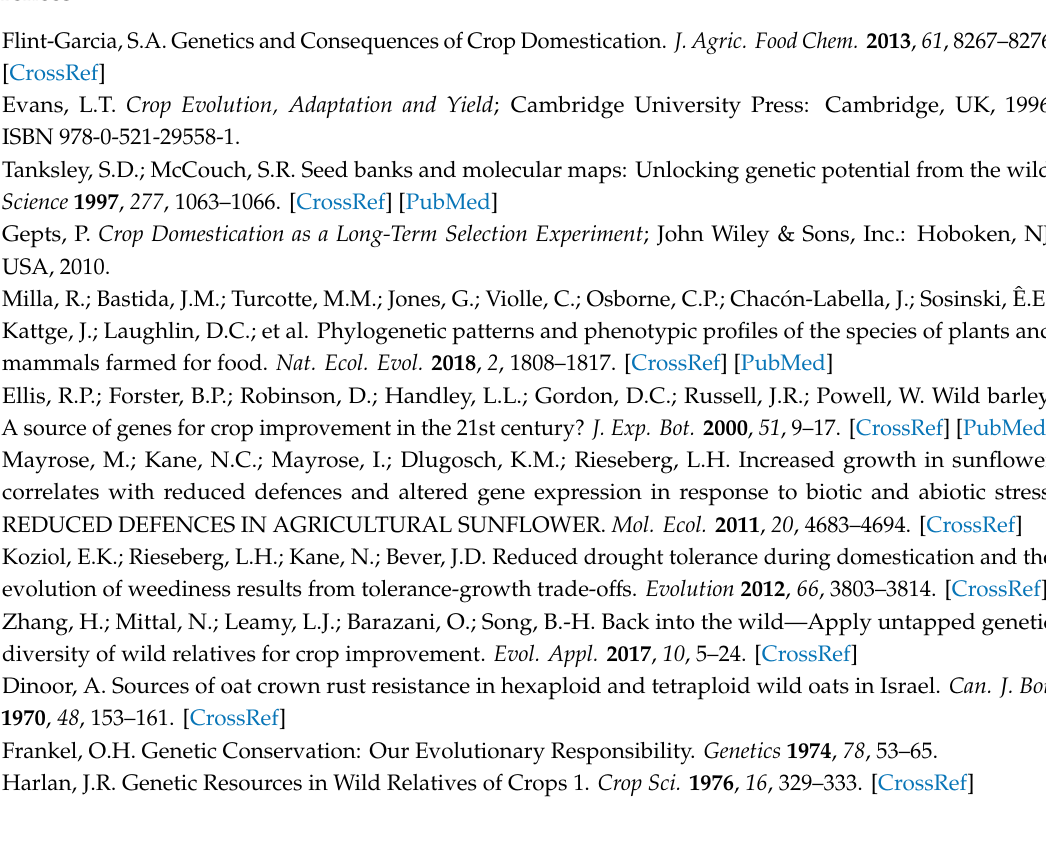
Figure S1: Elemental Content within Tissue Type, Figure S2: Element MRAA within Tissue Type, Figure S3: Top Three Size-Independent Traits from PC1 Axis under Stress Treatment against Expectation-deviation Tolerance, Figure S4: Elemental Content by Tissue Type of Twelve Elements, Figure S5: Elemental Allocation by Tissue Type of Twelve Elements, Table S1: Accession List, Table S2: Elemental PC Loading Contributions, Table S3: Associations of Both Metrics of Tolerance with Elemental Content and Allocation for Twelve Elements, Table S4: Mean Elemental Content and Allocation of Twelve Elements and p -value Significance of Wald’s Chi-square Test on Treatment, Domestication Status, and their